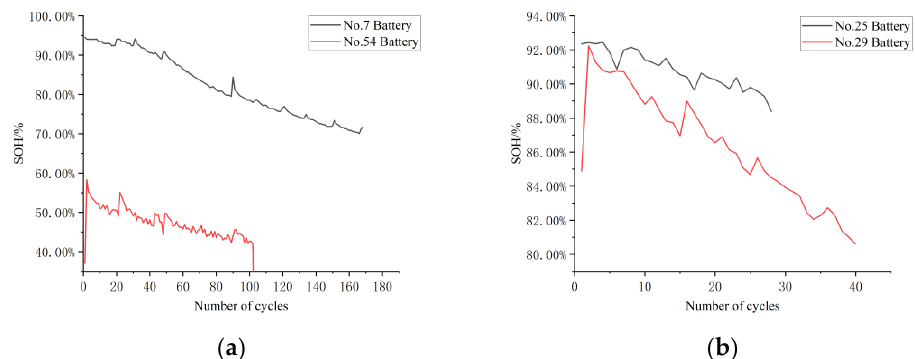
Figure 1. Change curve of SOH at different temperatures. ( a ) SOH change curve for battery 7 and battery 54. ( b ) SOH change curve for battery 25 and battery 29.